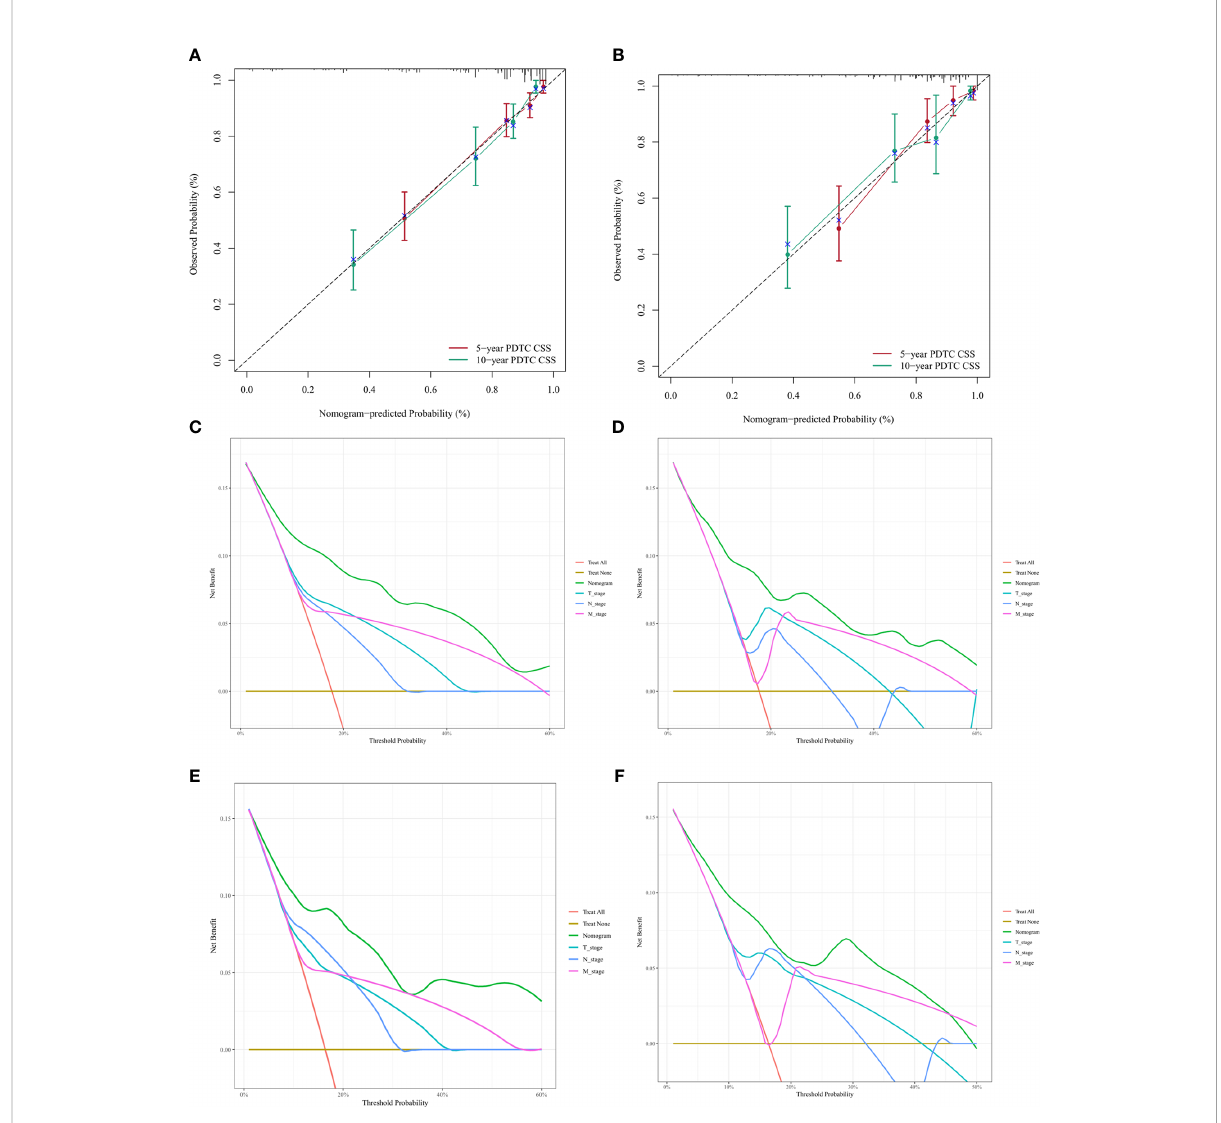
FIGURE 5 Calibration plots and decision curve analysis for predictions of cancer-speci fi c survival (CSS) in the training and validation cohort at 5 and 10 years.Calibration plots of the nomogram in training (A) and validitaion (B) cohorts. Decision curve analysis for the Nomogram and AJCC T-, N-, and M-stage in prediction of prognosis in training ( C , 5-year; D , 10-year) and validation ( E , 5-year; F , 10-year)